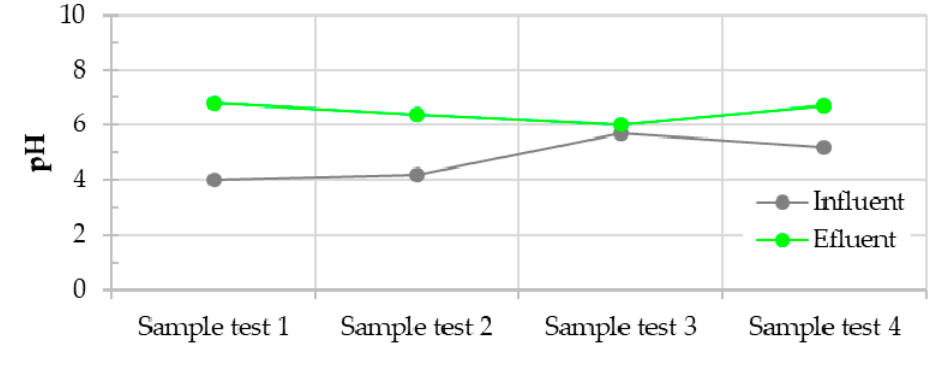
Figure 7. pH variation.